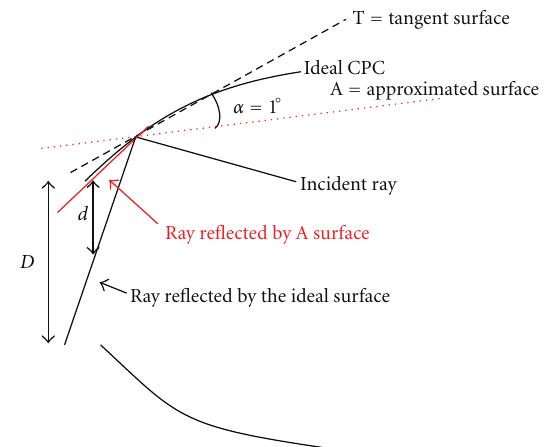
Figure 6: Geometry used in the corrected-power approximation method. D : diameter of the CPC exit port; d : distance of the two reflected rays measured on the exit port. The quantity relevant for the method is the relative displacement d/D . Drawing is exaggerated for better readability.